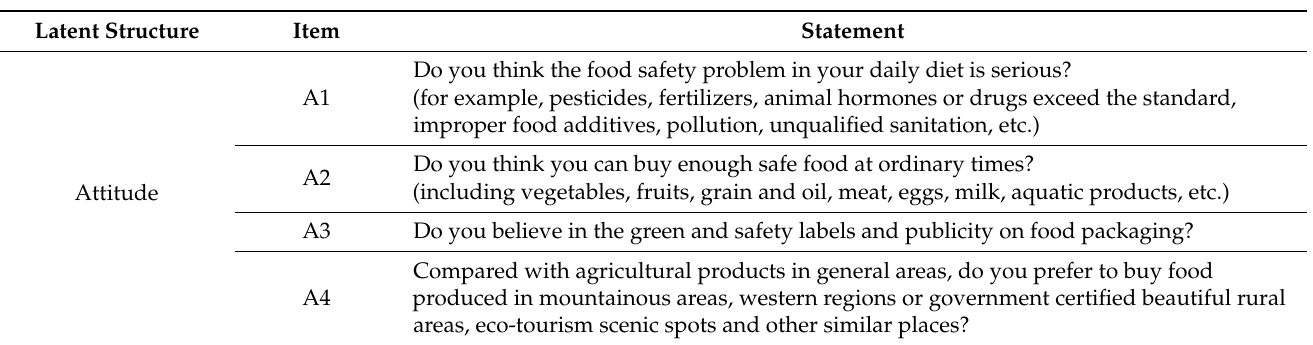
Table A1. Key issues of